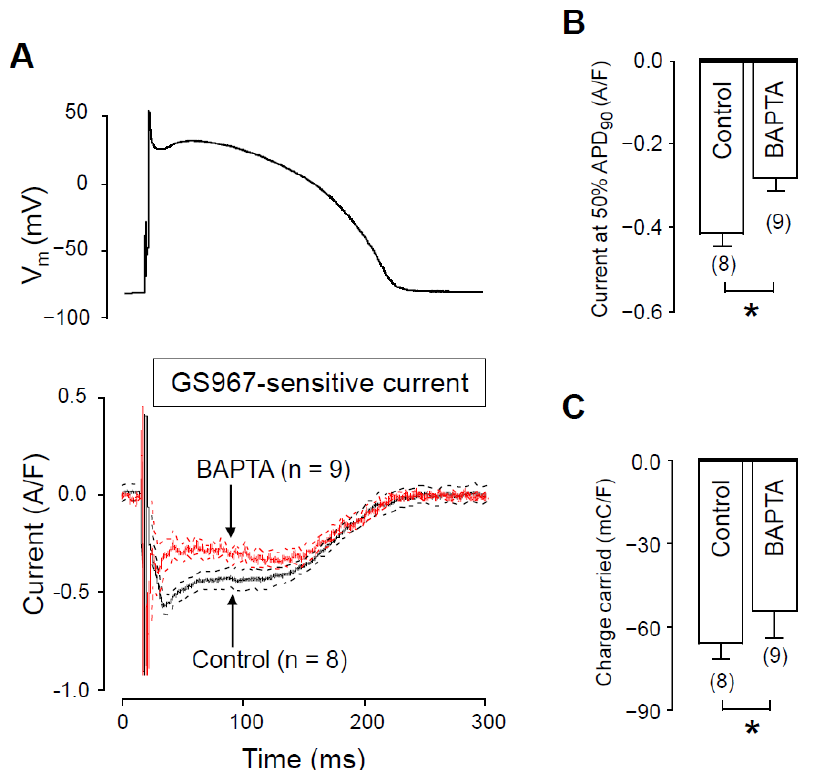
Figure 4. Effects of GS967 on I NaL under action potential voltage clamp conditions in control and in the presence of 10 mM BAPTA, added to the pipette solution. ( A ) The command AP (above) and GS967-sensitive current profiles (below) were obtained in the presence or absence of BAPTA. The records represent average data from eight and nine myocytes, respectively, and the dashed lines denote SEM values. ( B , C ) Average I NaL densities, measured at 50% of APD 90 ( B ) and current integrals ( C ) obtained in the absence and presence of BAPTA. Columns and bars are mean ± SEM, numbers in parentheses indicate the number of myocytes studied, asterisks denote significant differences between the BAPTA-treated and control groups.